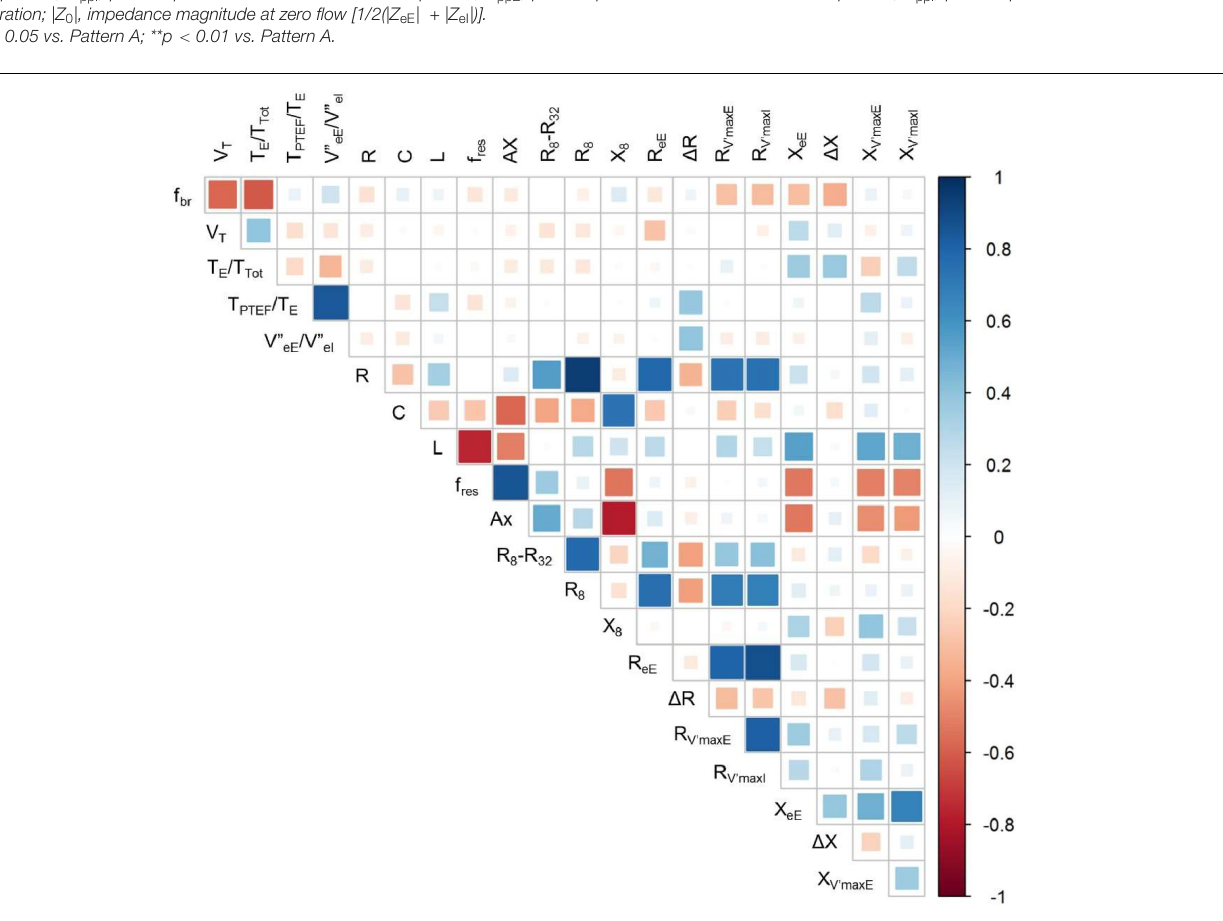
lung volume in the early phase of postnatal lung and chest wall development (22). The small but highly significant increase in the T E /T Tot ratio in this group ( Table 1 ) supports the above argument. Intuitively, a similar change in Xrs but in